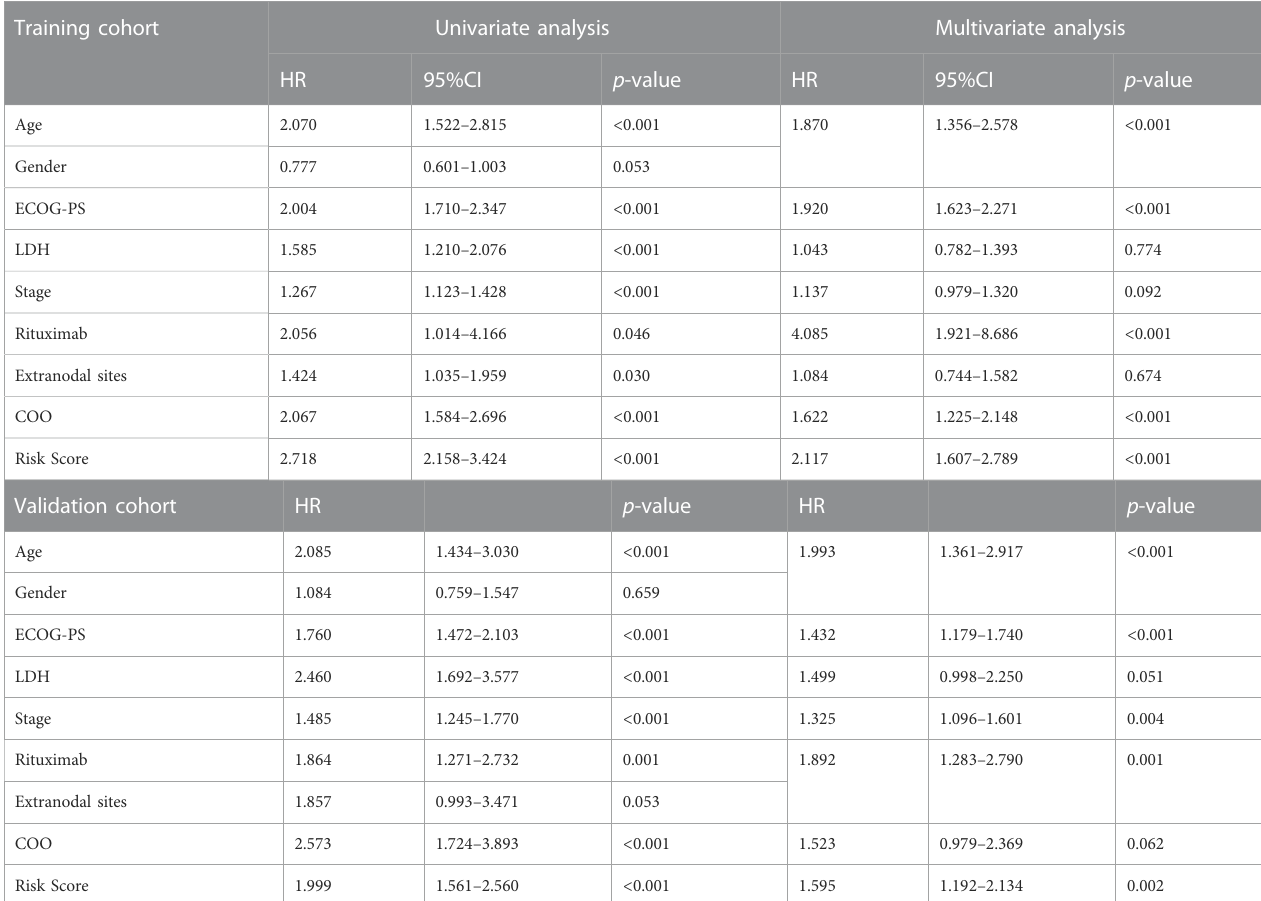
TABLE 2 Univariate and multivariate Cox regression analyses of clinicopathological parameters in training and validation